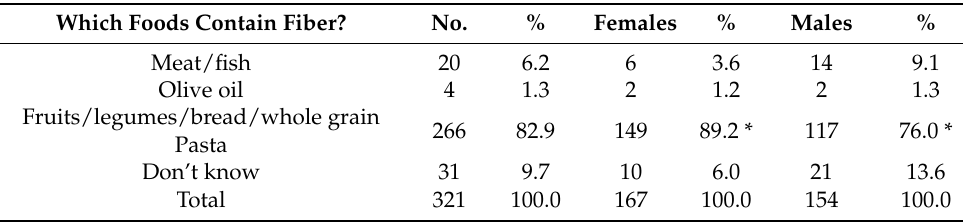
Table 6. Knowledge of fiber-containing